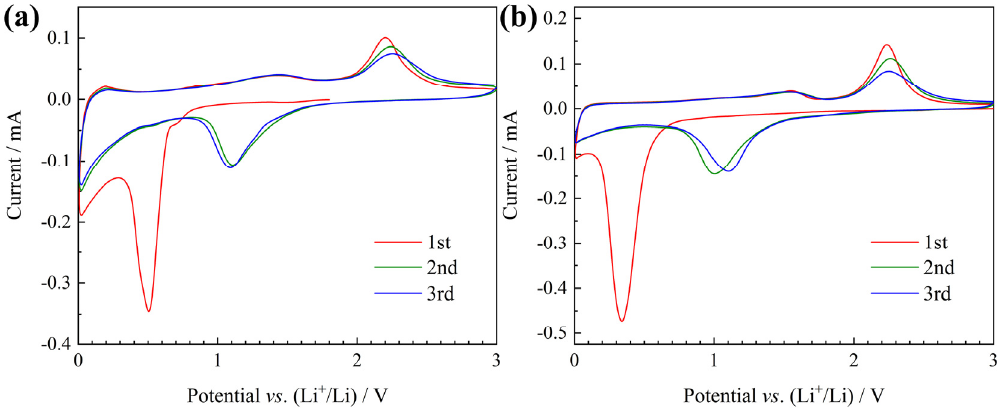
Figure 7. Cyclic voltammetry (CV) curves of ( a ) the NiO/C and ( b ) NiO electrodes.